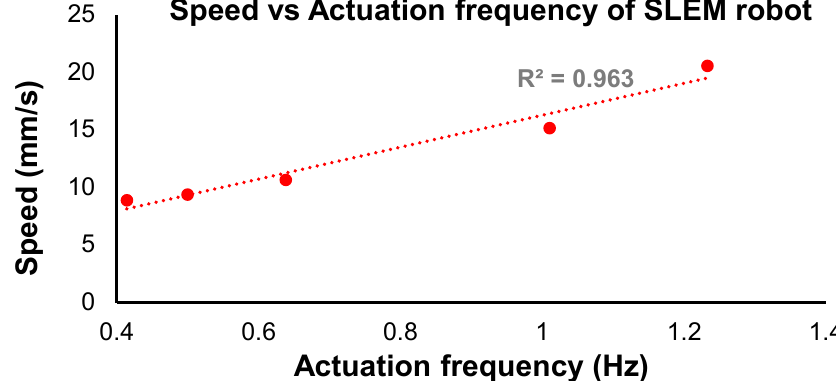
Figure 14. Speed (mm/s) against actuation frequency (Hz) for SLEM.